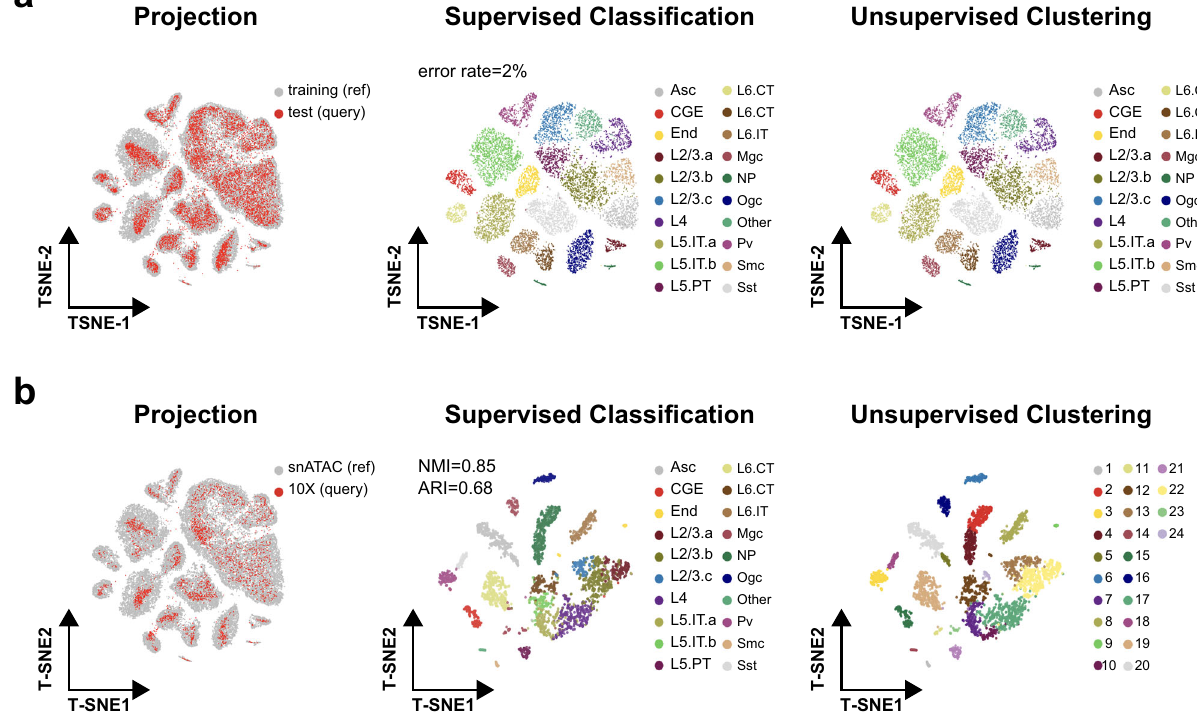
Fig. 6 SnapATAC enables supervised annotation of new scATAC-seq dataset using reference cell atlas. a MOs snATAC-seq dataset is split into 80% and 20% as training and test dataset. A predictive model learned from the training dataset predicts cell types on the test dataset of high accuracy (left) as compared to the original cell-type labels (right). b A predictive model learned from the reference dataset — MOs (snATAC) — accurately predicts the cell types on a query dataset from mouse brain generated using a different technological platform, the 10× scATAC-seq. The t-SNE embedding is inferred from the reference cell atlas (left) or generated by SnapATAC in an unbiased manner from 10× mouse brain dataset (middle and right). Cells are visualized using t-SNE and are colored by the cell types predicted by supervised classi fi cation (middle) compared to the cluster labels de fi ned using unsupervised clustering